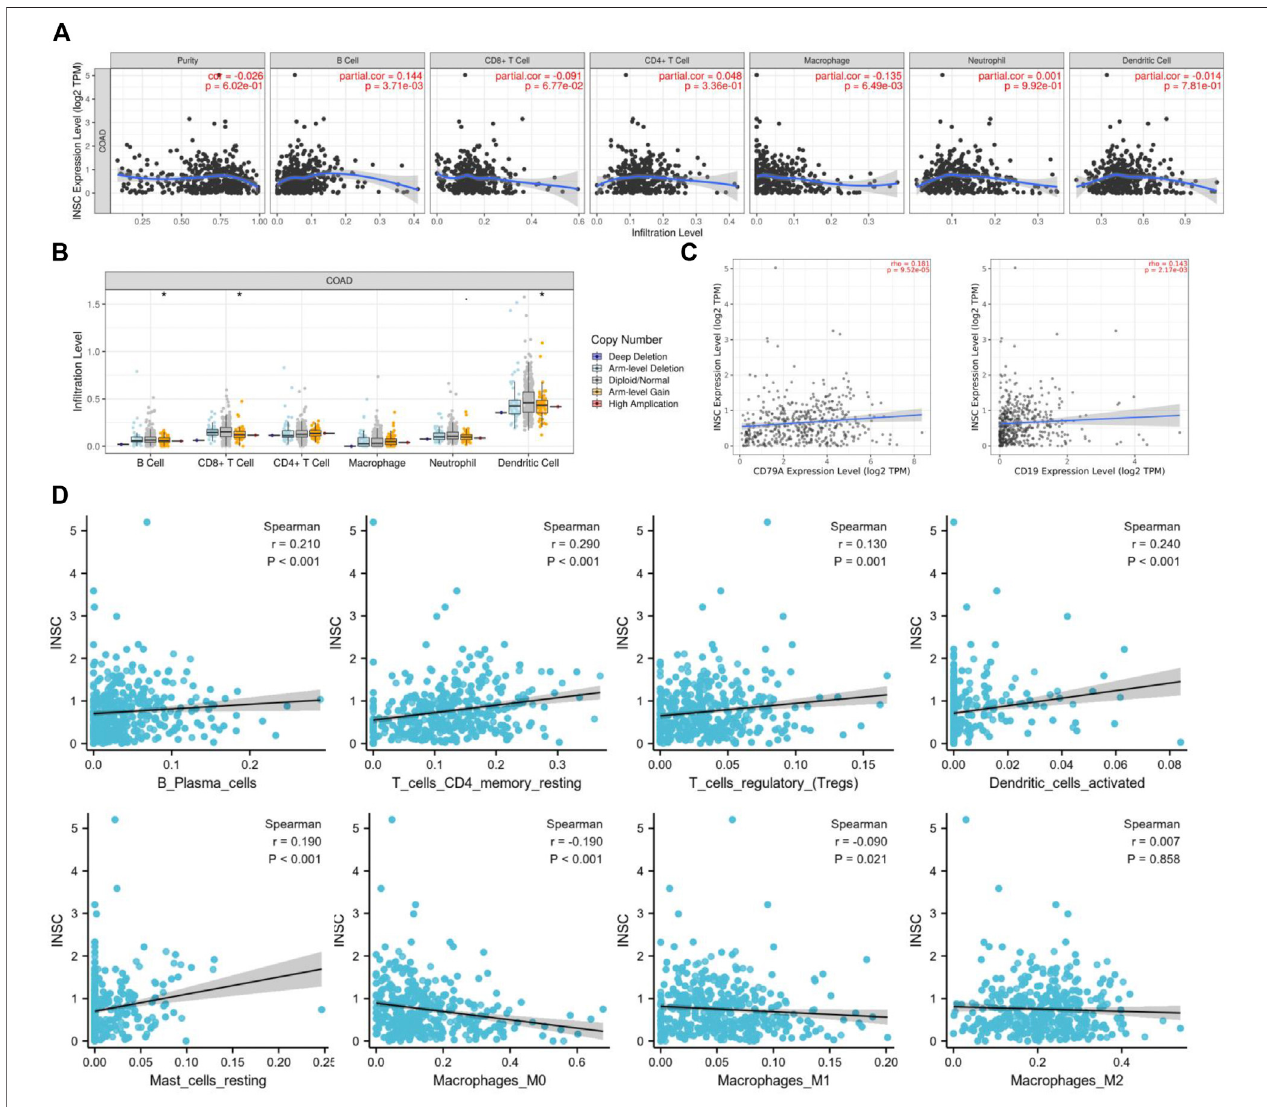
FIGURE 7 | Correlations of INSC expression with TIIC in fi ltration level in COAD. (A) The correlation of INSC expression with tumor purity and TIIC from the TIMER database. (B) TheeffectofINSCCNVonthein fi ltrationlevelsofimmunecellsinCOAD. (C) RelationshipbetweenINSCandBcellmarkerssuchasCD79AandCD19. (D) The effect of INSC on the level of TIIC in fi ltration in COAD using the CIBERSORT method (*, p < 0.05, **, p < 0.01, ***, p < 0.001).